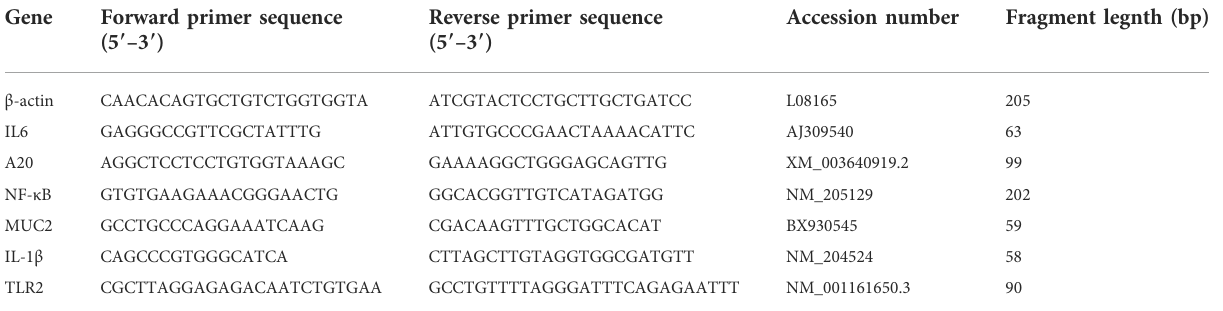
TABLE 4 The sequence of primers for qRT-PCR.